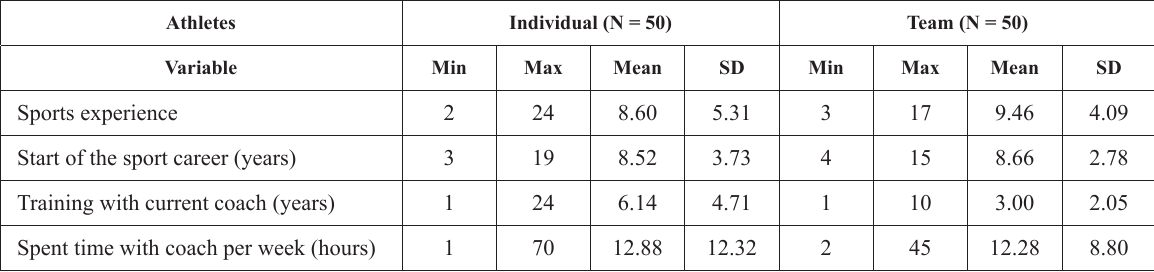
Table 1. Information about the athletes